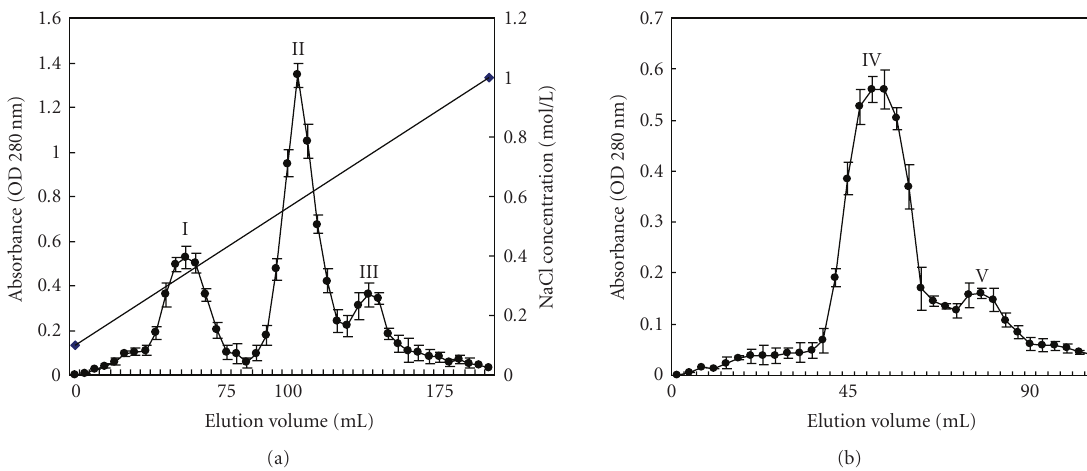
Figure 2: (a) Fractionation of the crude extract of red kidney bean lectin by DEAE Sephadex A-50 ion-exchange chromatography equilibrated with 0.1M NaCl in 0.02 M Tris-HCl (pH 8.0). The column was washed initially with the same bu ff er to remove proteins that were not specifically absorbed to the column (data not shown on the figure) then washed with bu ff er in which the NaCl concentration increased linearly from 0.1M to 1.0M. Three peaks were obtained, among which peaks II and III exhibited hemagglutinating activity. Column: 2.6cm × 60 cm; flow rate: 0.5mL/min. (b) Fractionation of peak II on a Sephadex G-150 column with 0.15 M NaCl in 0.02 M Tris-HCl (pH 8.0). Column: 2.6cm × 60cm; flow rate: 1mL/min. Only the major peak (peak IV) exhibited hemagglutinating activity. Data represent means ± SD ( n = 6).